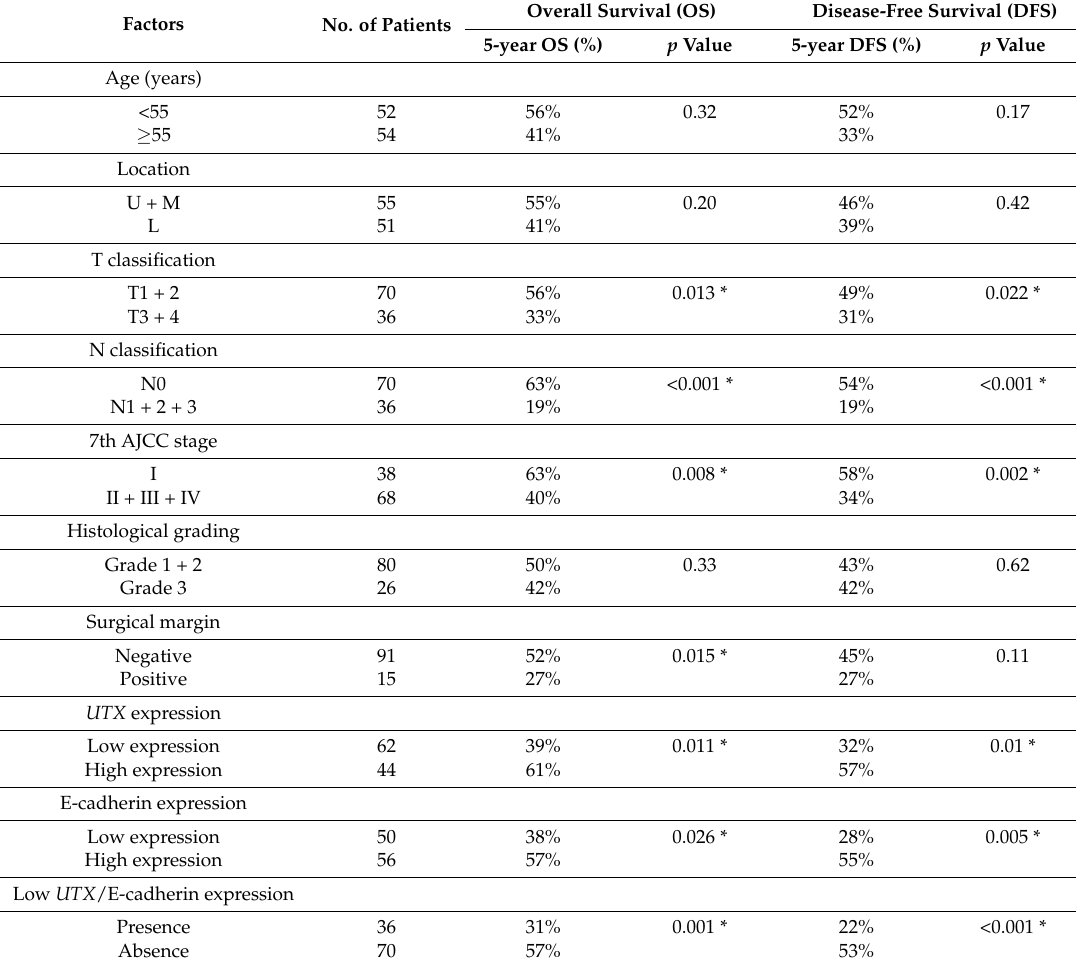
Table 3. Results of univariate log-rank analysis of prognostic factors for overall survival (OS) and disease-free survival (DFS) in 106 patients with ESCC receiving